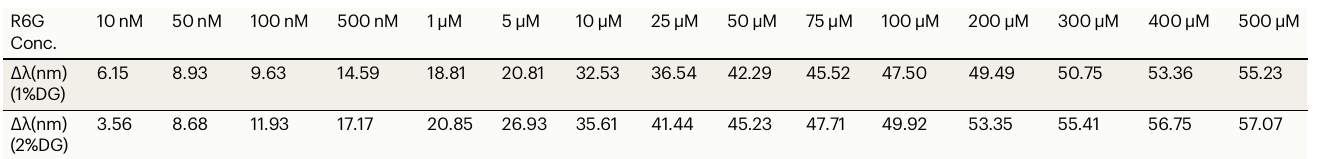
Table 1 | Δλ ( λ R6G - λ DG ) values at same R6G concentration with different DG-doping R6G